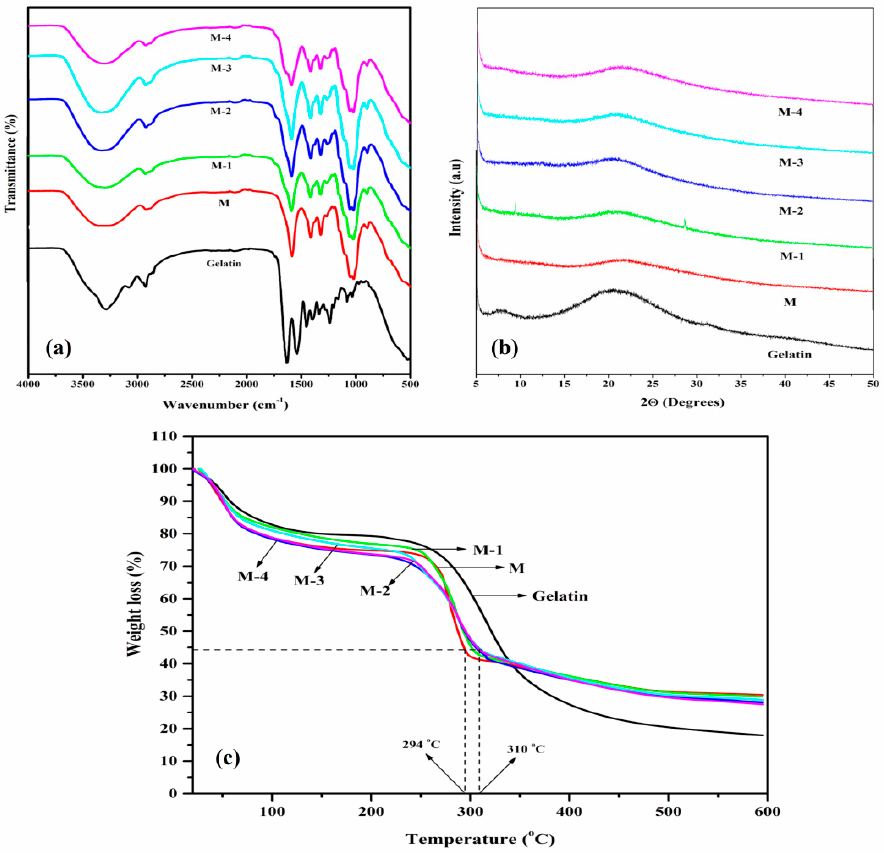
Figure 2. ( a ) FTIR spectra; ( b ) wide-angle X-ray diffraction; ( c ) thermogravimetric analysis patterns of Ge; NaCMC (M); and Ge-incorporated NaCMC membranes: (M-1) 5 mass%; (M-2) 10 mass%; (M-3) 15 mass%; (M-4) 20 mass% of Ge.